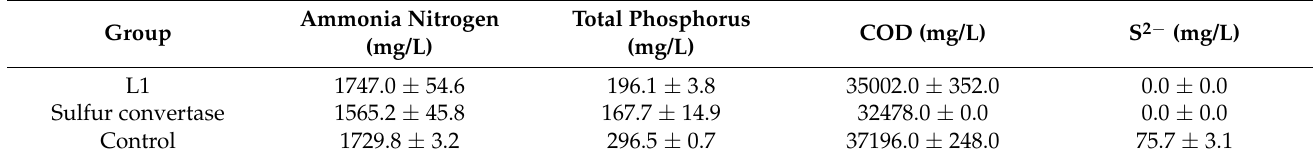
Table 3. The change of wastewater indicators and S 2 −